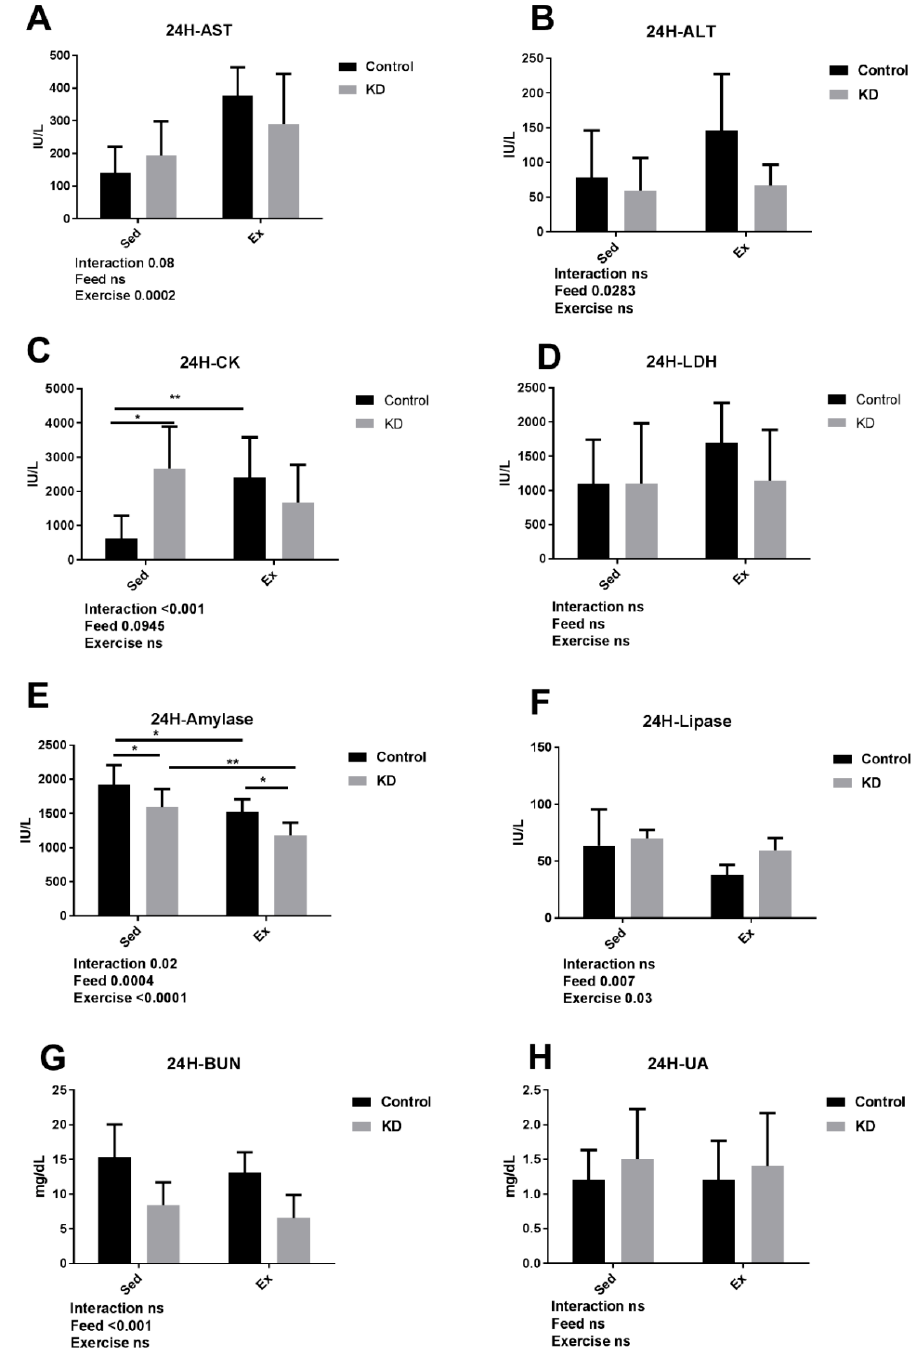
Figure 5. Plasma organ damage markers 24 h after exhaustion. ( A – H ) Concentrations of plasma aspartate transaminase (AST), alanine transaminase (ALT), creatine kinase (CK), lactate dehydrogenase (LDH), amylase, lipase, blood urea nitrogen (BUN) and urea acid (UA). * p < 0.05, ** p < 0.01.